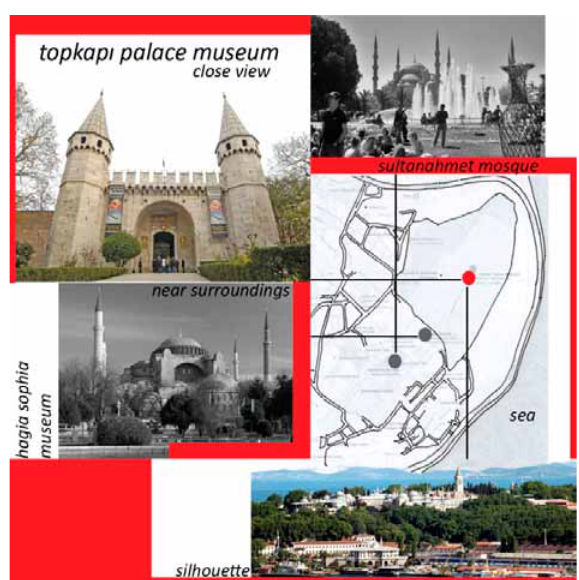
fig. 9. Topkapi Palace Museum, collage by